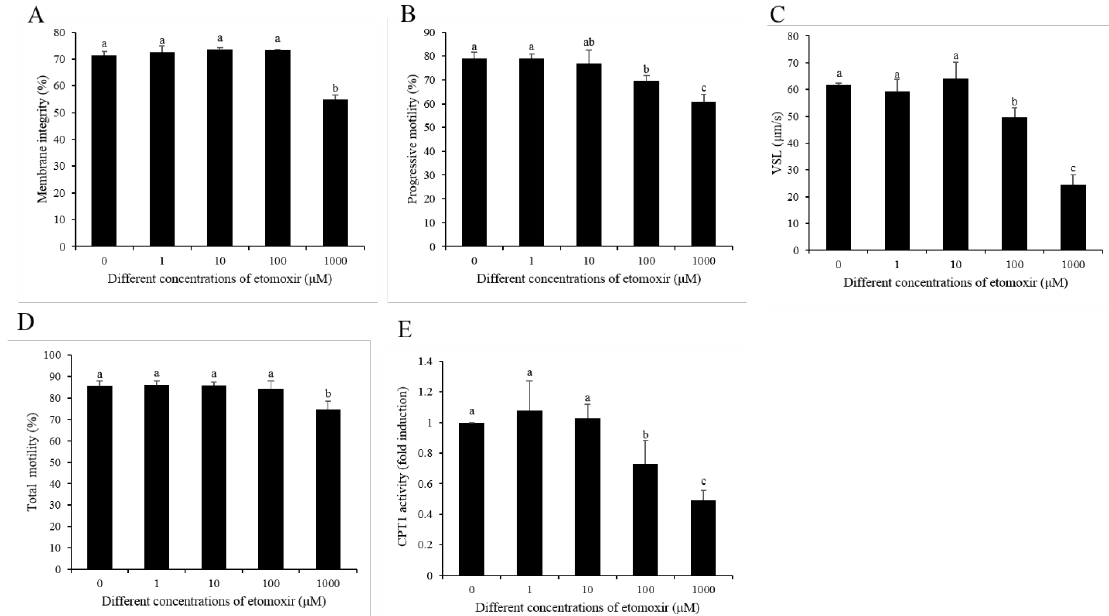
Figure 9. (A–C) Effects of different concentrations of etomoxir, an inhibitor of β-oxidation, on sperm membrane integrity (A), progressive motility (B), VSL (C), total motility (D), and CPT1 activity (E). Data are the mean ± standard deviation (SD). Columns with different lowercase letters differ significantly ( p ＜ 0.05).